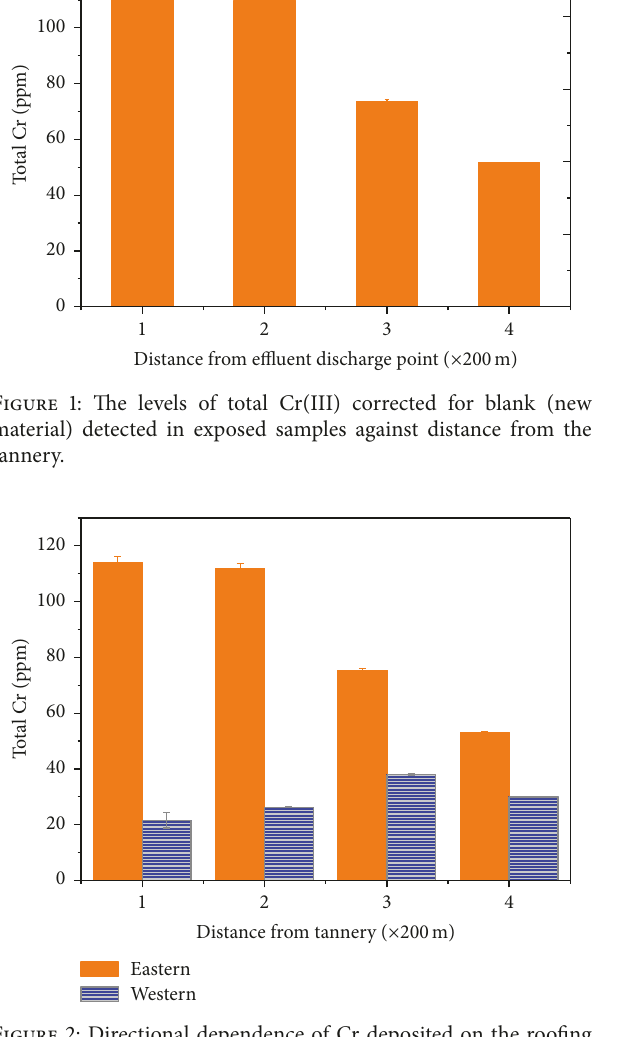
Figure 2: Directional dependence of Cr deposited on the roofing material.